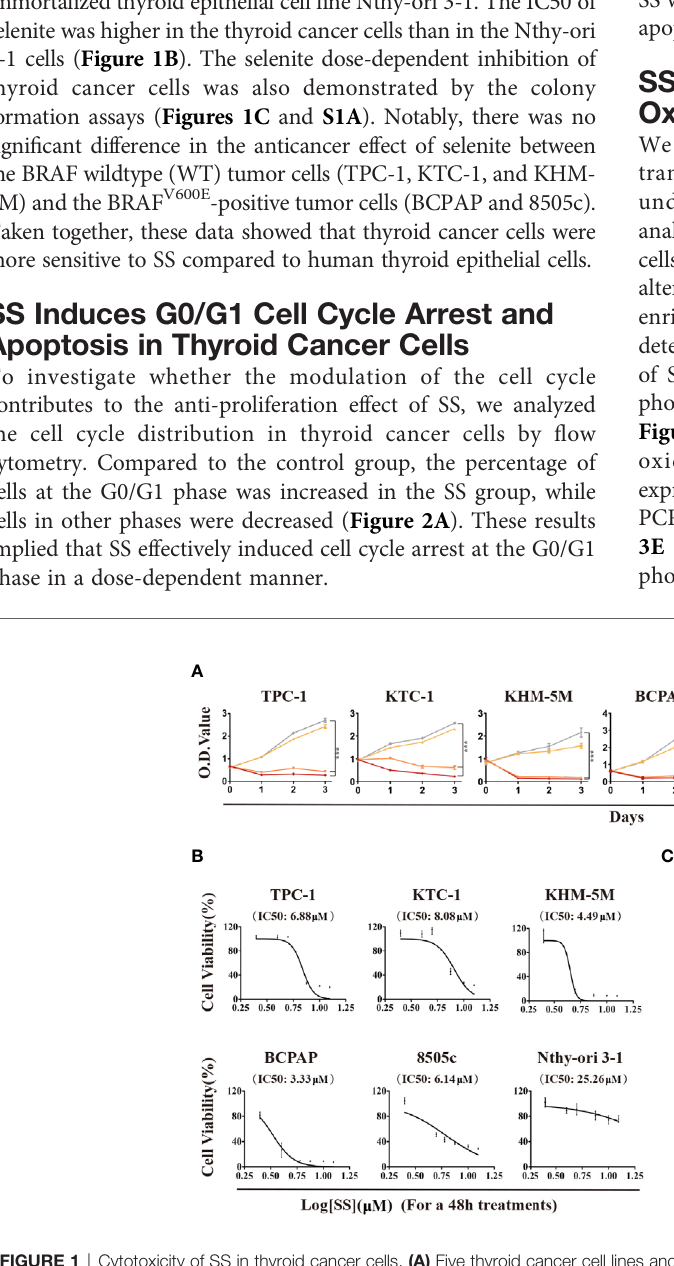
FIGURE 1 | Cytotoxicity of SS in thyroid cancer cells. (A) Five thyroid cancer cell lines and one thyroid epithelial cell line were treated with different concentrations of SS for the indicated times. Cell viabilities were determined by CCK8 assays. (B) Half maximal inhibitory concentration (IC50) values were calculated using the Reed – Muench method. (C) Effect of SS on cell growth based on colony formation assays. SS, sodium selenite. ***P <